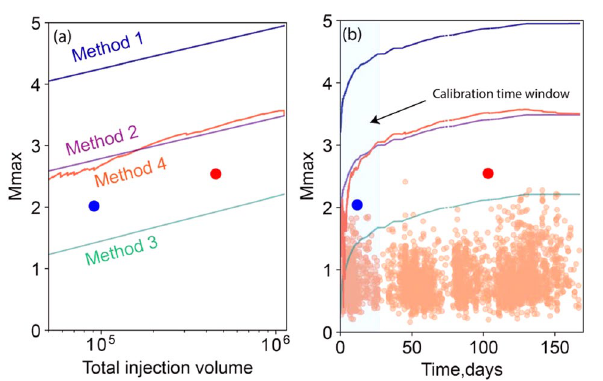
Figure 6. Comparison of estimated upper limits of seismic event magnitude in project area one. ( a ) Estimated M max versus total injection volume for the four short-term forecasting methods. Only events above the magnitude of completeness (0.8 M W ) are considered for models 2–4. The blue and red symbols show the largest magnitude of induced seismic events during the calibration window and entire dataset, respectively. ( b ) Estimated M max versus time. Small orange symbols show observed magnitudes for all